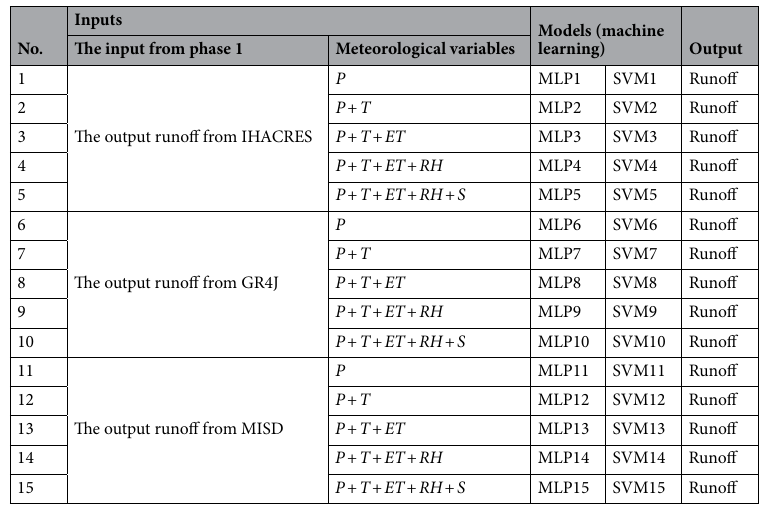
Table 7. Intended scenarios for the implementation of coupled scenarios (machine learning via hydrological